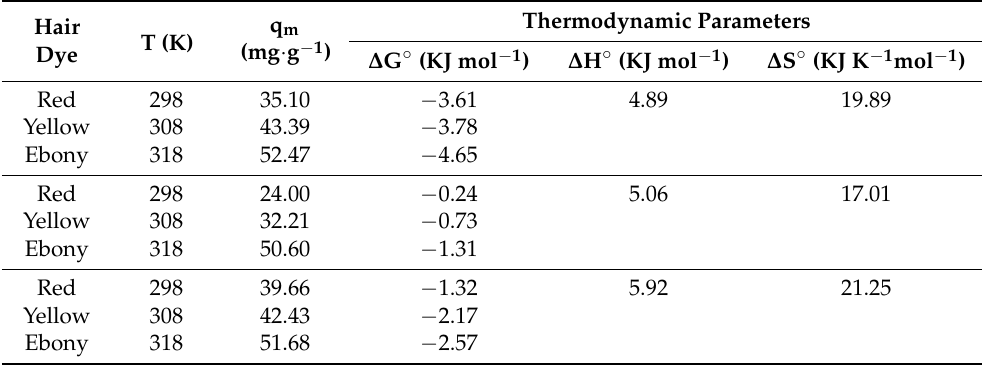
Table 4. Thermodynamic parameters of adsorption of hair dyes (R, Y, and E) onto COZ.